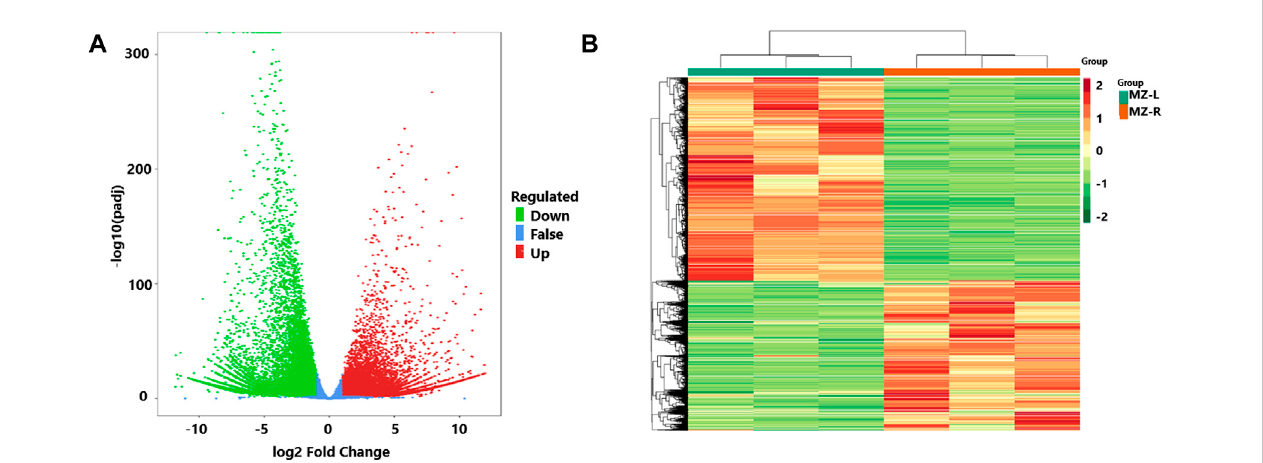
FIGURE 2 (A) The volcano plot of genes with differential expressions (DEGs) from leaf and root samples of V. mengtzeanum and revealing upregulation (red dots) and downregulation (green dots) and the non-differentially expressed genes (blue dots). The abscissa ( X -axis) indicates the Change in gene expression multiples, and the ordinate ( Y -axis) indicates the differential gene ’ s signi fi cance level. (B) The heatmap of FPKM values is based on differential expressions of leaf and root samples of V. mengtzeanum . The abscissa ( X -axis) indicates the sample name and hierarchical clustering results, and the ordinate ( Y -axis) indicates the differential gene and hierarchical clustering results. Red indicates high expression and green indicates low